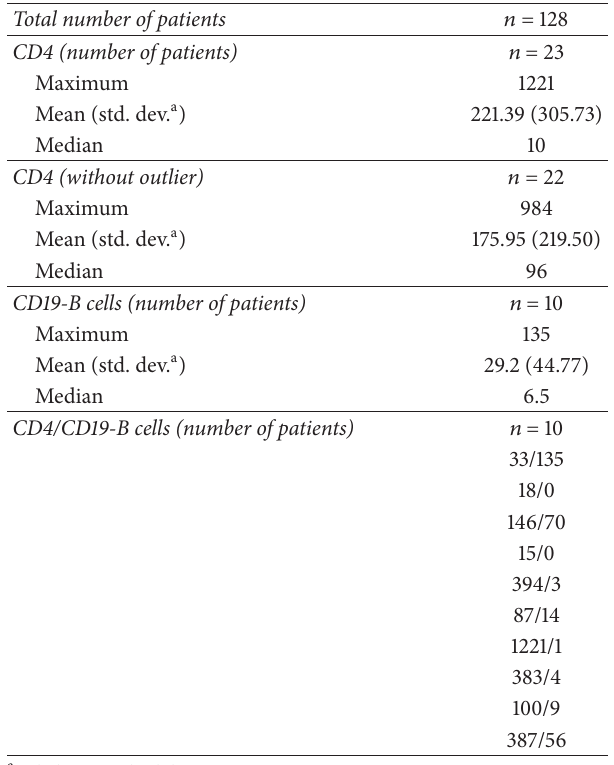
Figure 2: Requirement for mechanical ventilatory support (IMV: invasive mechanical ventilation, NIMV: noninvasive mechanical ventilation). Table 4: Laboratory data in non-HIV patients with PCP.